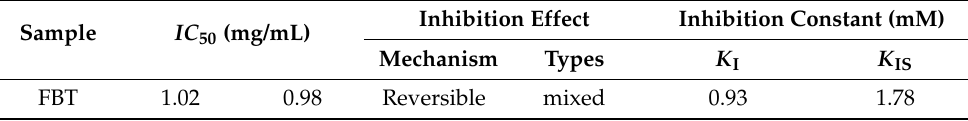
Figure 2. Inhibition of lipase by FBT and its mechanism. ( A ) Effect of FBT on lipase activity. ( A-a ) IC 50 value of FBT; ( A-b ) Slope diagram of enzyme activity at different FBT concentrations. ( B ) Type of lipase inhibition by FBT. ( B-a ) Lineweaver–Burk double reciprocal curve; ( B-b ) double reciprocal curve slope plotted against effector concentration to determine inhibition constant K I ; ( B-c ) double reciprocal curve intercept versus effector concentration plot to determine the inhibition constant K IS . ( C ) Effect of FBT on lipase emission spectrum. ( C-a ) Stratification of lipase fluorescence emission spectra; ( C-b ) Absorption peak height pair [I]; ( C-c ) Stern–Volmer curve; ( C-d ) Lg [(F 0 -F)/F] stands for LG [I]. ( D ) Molecular docking mode of FBT and lipase residues. Table 1. Inhibition constants of FBT on